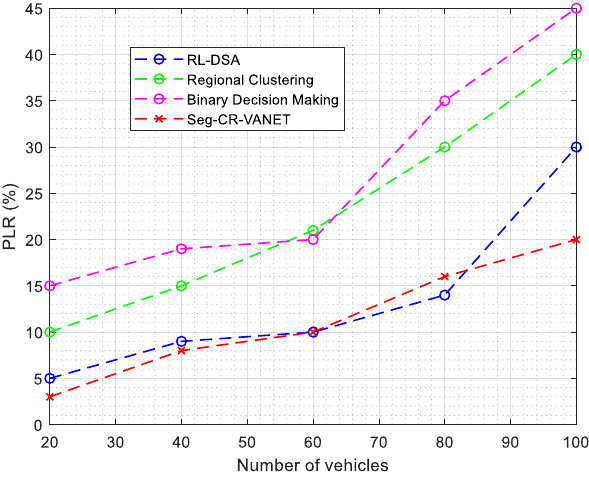
Figure 13. Comparison of PLR.